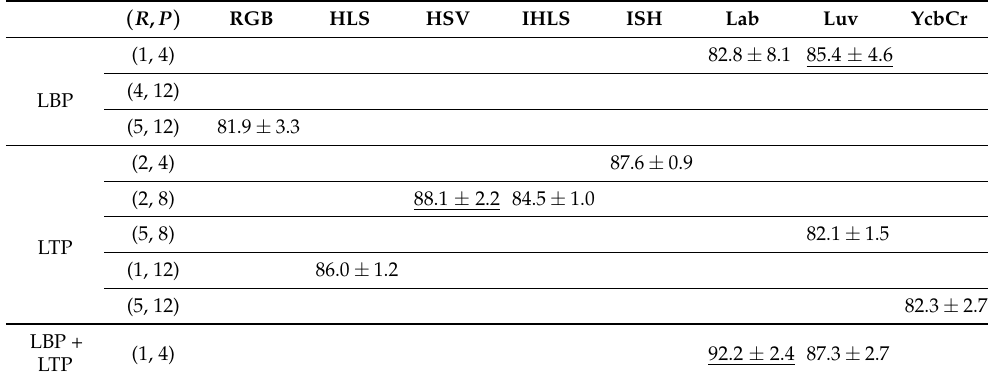
Table 4. The best results obtained for Cloud-ImVN 1.0 dataset without using histogram selection method. The best results for each color space, each feature, and the selected parameters ( R , P ) .